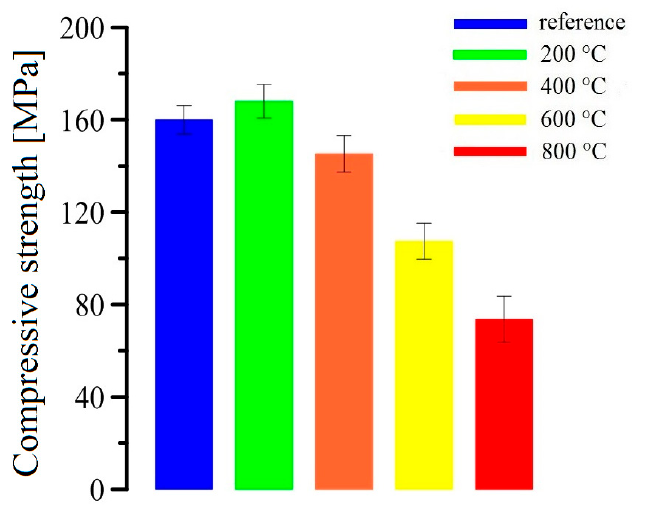
Figure 9. Compressive strength of UHPC specimens after their exposure to elevated